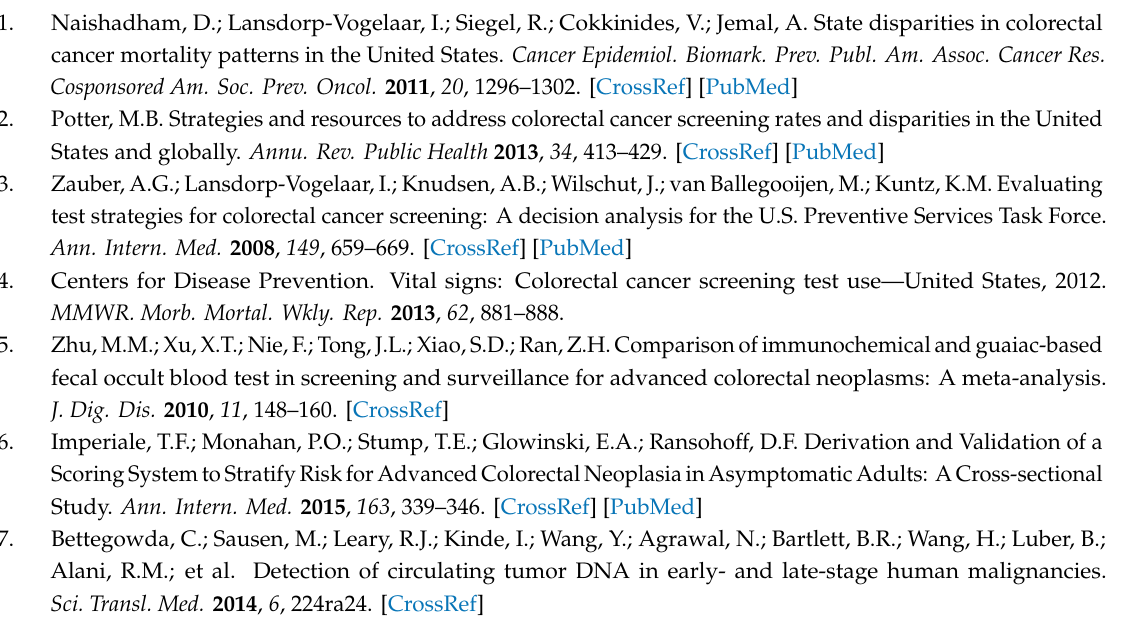
Figure S1, Table S1: Data of cytokine induced p-STAT signature in peripheral blood cells, directly or indirectly cultured with